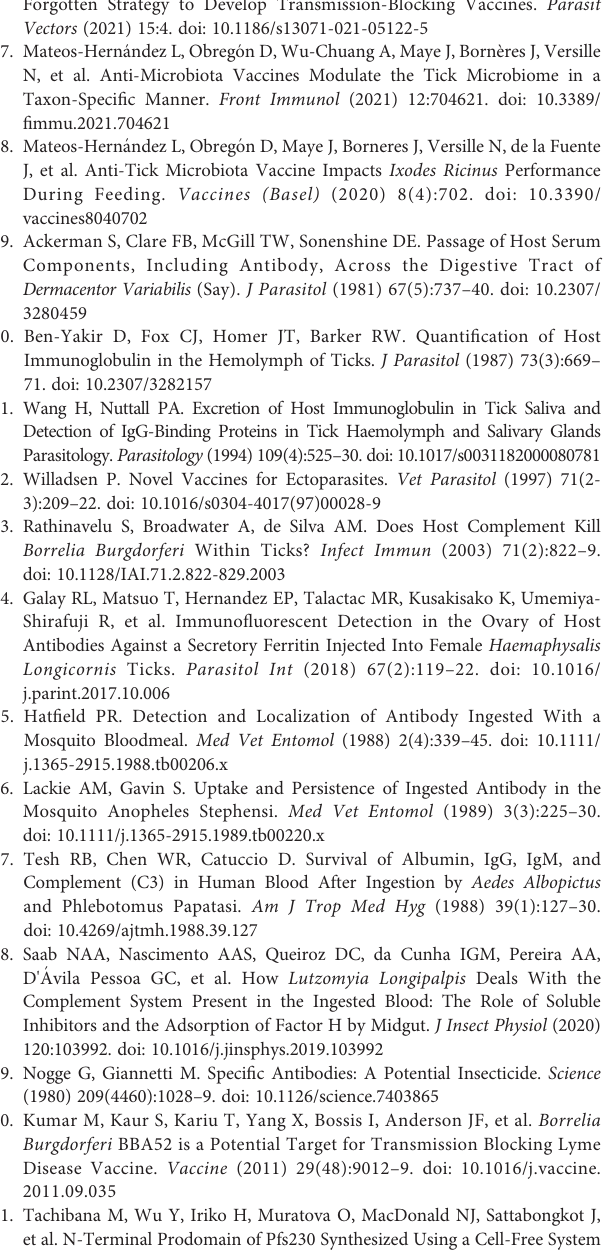
Supplementary Figure S1 | Impact of anti-microbiota vaccines on fecal microbiota of birds. Comparison of ASV richness and evenness, measured with (A) Faith ’ s phylogenetic diversity index and (B) Pielou ’ s evenness index, respectively, among the microbiota of mock-immunized, E. coli BL21-immunized and E. coli O86:B7-immunized birds.